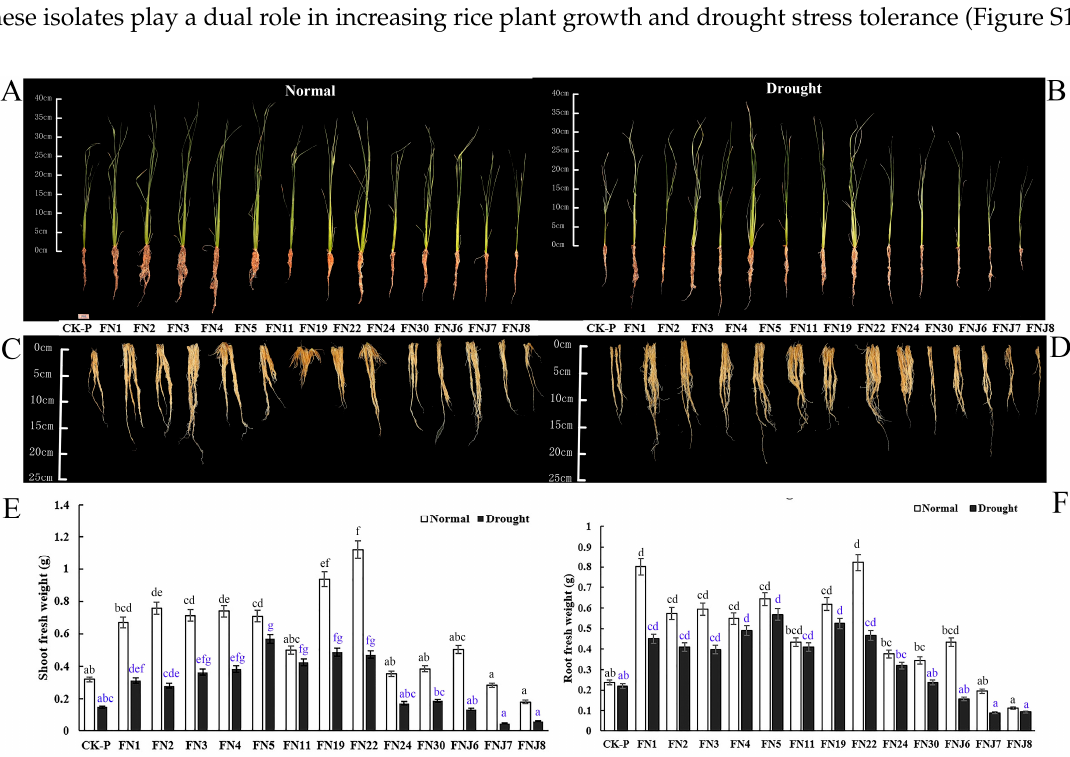
Figure 2. Differential fungal effects on rice growth and drought tolerance. ( A–D ) Representative images of rice shoot and root inoculated with endophyte and rhizosphere fungi compared to non-inoculated plants under well-irrigated and drought stress. ( A ) Rice images under well-irrigated. ( B ) Rice images under drought stress. ( C ) Rice root images under well-irrigated. ( D ) Rice root images under drought stress. ( E ) Shoot fresh weight. ( F ) Root fresh weight. N = 14. Abbreviations shown in Table 1. Different lowercase letters indicate significant differences of shoot or root fresh weight among treatments (ANOVA analysis, Means followed by the different letter are significantly different, P = 0.05).